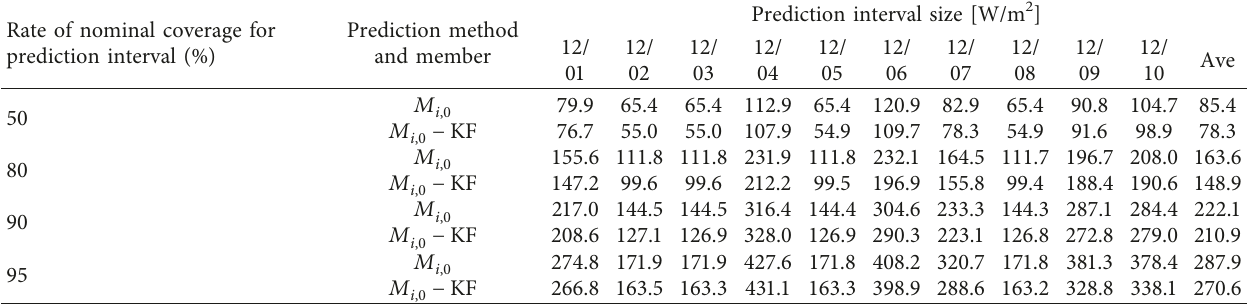
Table 4: Prediction interval sizes for the intraday solar GHI prediction with regard to the prediction interval of the ensemble prediction during the period from December 1 to 10 in